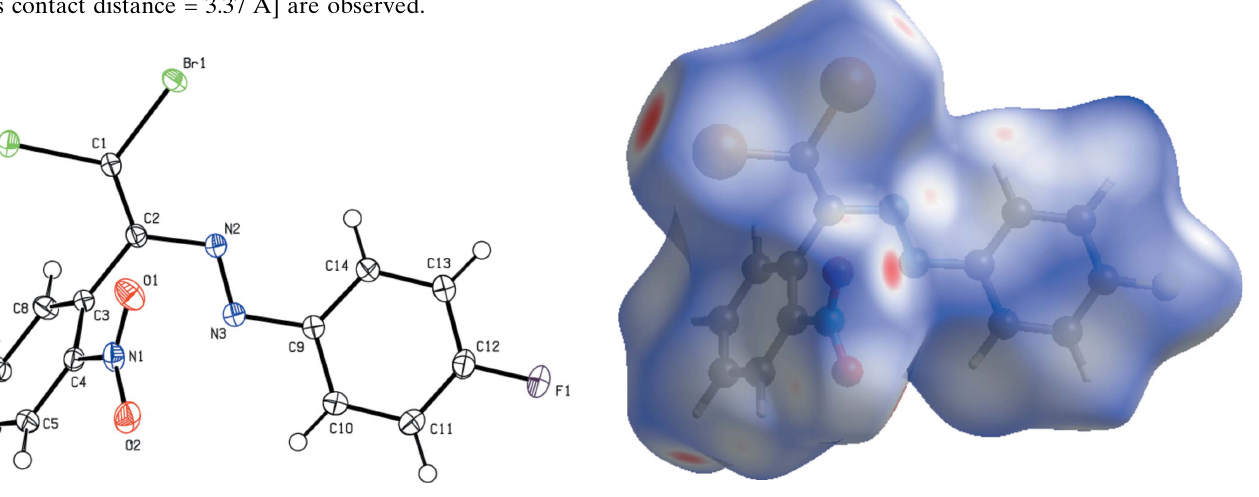
Figure 1 The molecular structure of the title compound with displacement ellipsoids drawn at the 50% probability level.